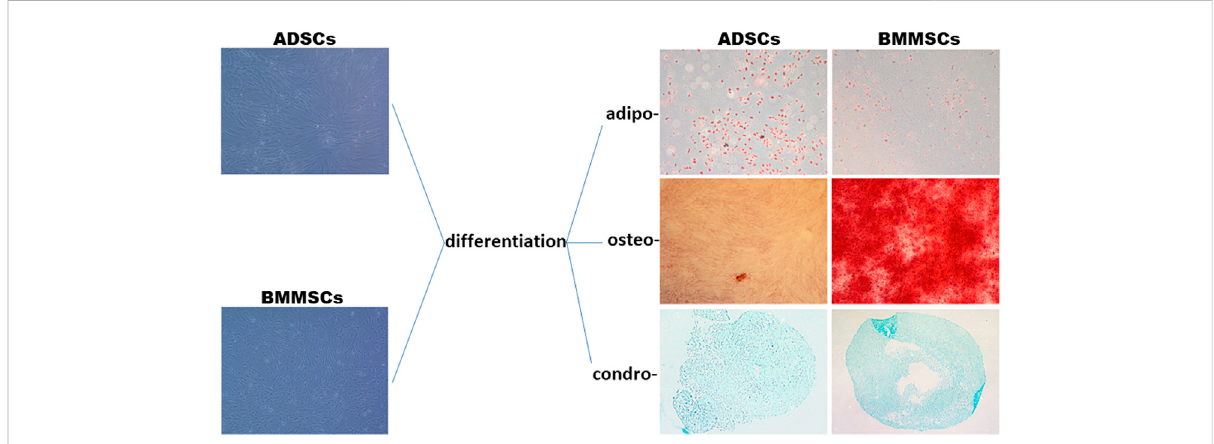
FIGURE 5 Stemness of ADSCs and BMMSCs was indicated by differentiation along three mesenchymal lineages, adipo-, osteo- and chondro-. Adipogenesis was evaluated by staining of lipid droplets with Oil Red O. Osteogenesis was evaluated by Alizarin Red S staining of the extracellular mineralized matrix. Chondrogenesis was determined by Alcian Blue staining of proteoglycan. All images were taken at ×20 magni fi cation. Four independent experiments in duplicate were